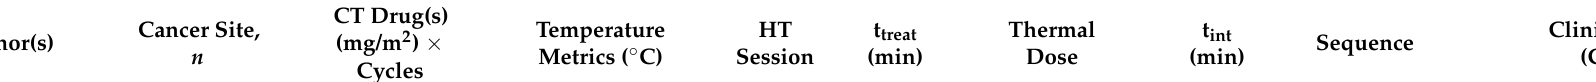
Table 9. Prospective clinical studies using CT in combination with